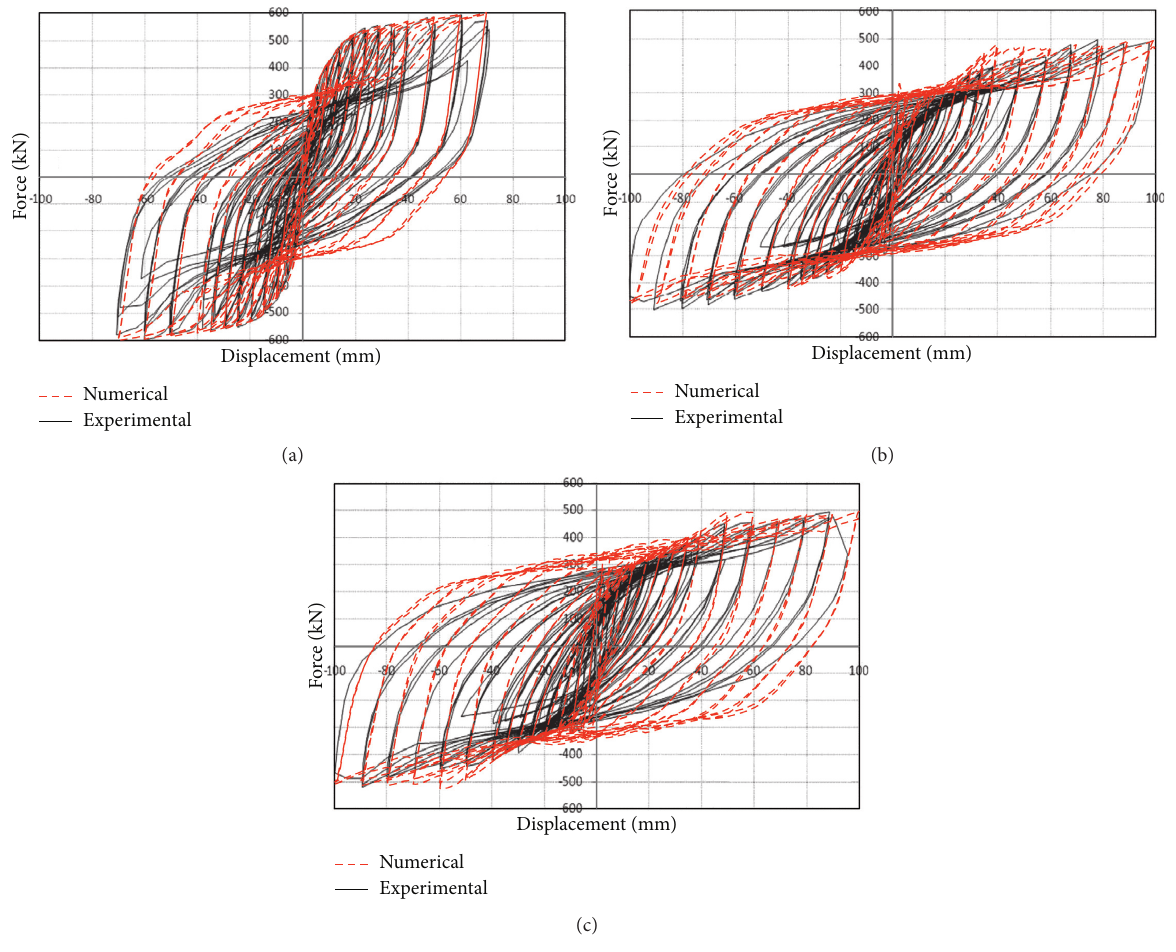
Figure 9: Comparison between experimental and computational results for the SPSWs tested by Emami et al. (a) Flat SPSW. (b) Horizontal corrugated SPSW. (c) Vertical corrugated